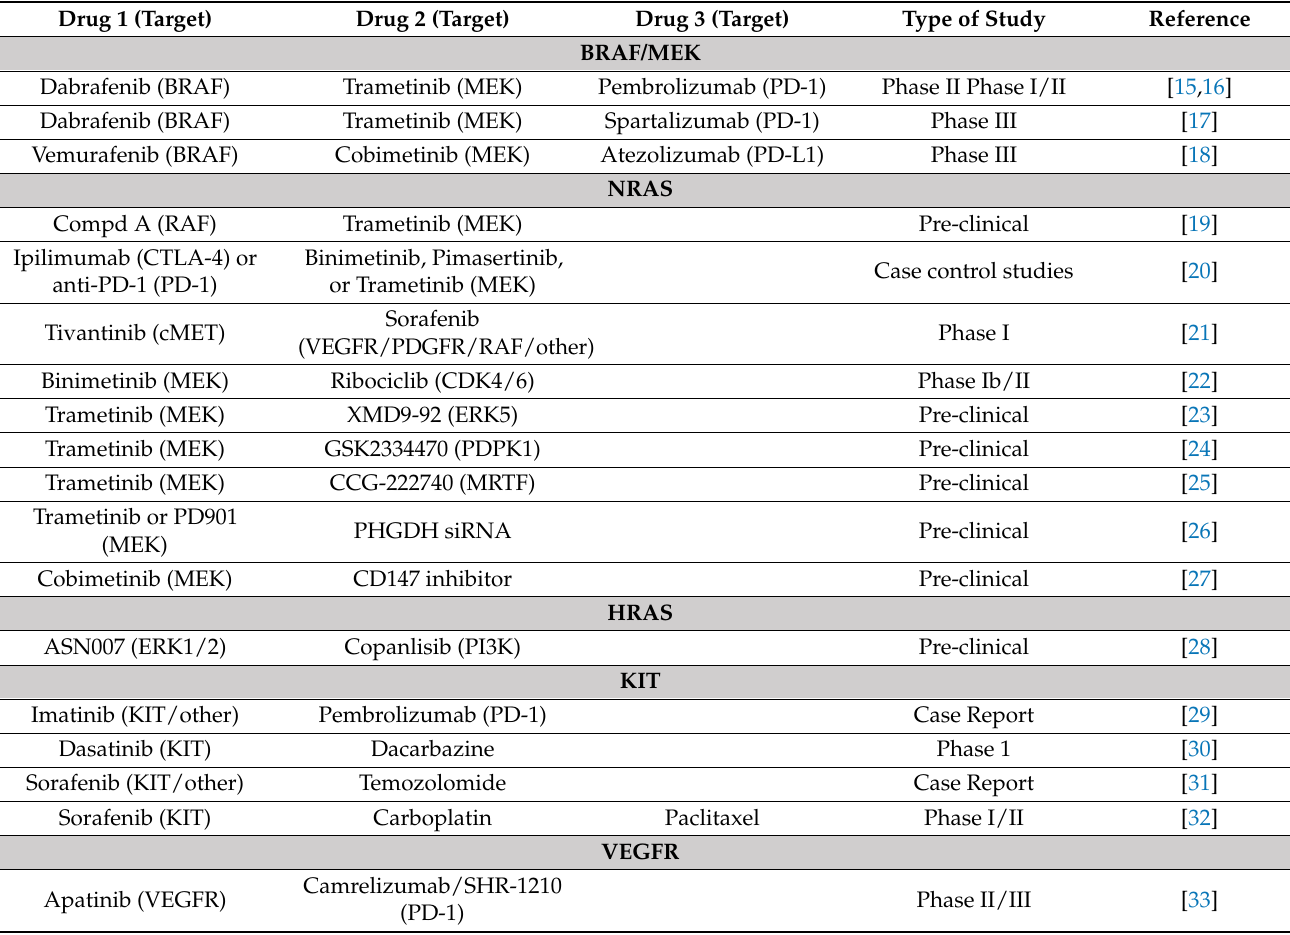
Table 1. Combination therapies for